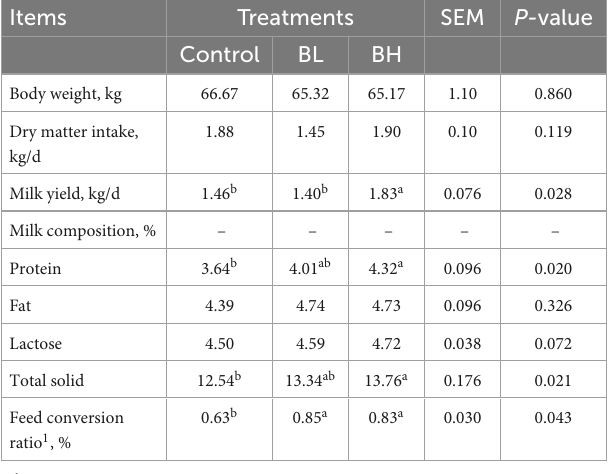
TABLE 2 Effects of biochanin A on body weight, dry matter intake, milk yield, and composition.